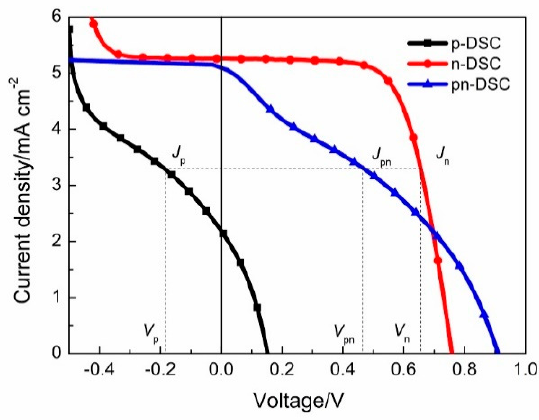
Figure 3. The simulated J-V curve of pn-DSCs from the corresponding n-DSC and p-DSC. − / − The reported P-DSCs in the literature that are based on the I I 3 electrode and NiO exhibited a very low V oc typically below 0.2 V and a FF between 30–40% [33]. Figure 4 shows the typical J-V characteristics of a p-DSC from our experimental samples. Details of J-V characteristics are shown in − 2 Table 1, the p-DSC exhibits a PCE of 0.12%, a V oc of 0.15 V, a J sc of 2.15 mA cm and a FF of 33.5%. Under negative bias, photocurrent density increases with the applied negative bias. When the negative bias exceeds 0.4 V (the threshold voltage of p-DSCs), there is a breakdown of p-DSCs, which exhibits a sharp increase in photocurrent density.